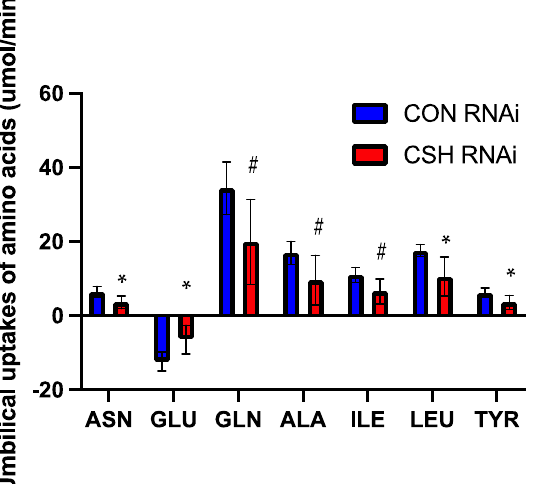
Figure 6. Umbilical uptakes (µmol/min) of amino acids as assessed by 3 H 2 0 transplacental diffusion at 130 dGA. Data are shown as means ± SEM for all pregnancies in each treatment group. CSH, chorionic somatomammotropin; RNAi, RNA interference. Ala, alanine; Asn, asparagine; Glu, glutamate; Gln, glutamine; Ile, isoleucine; Leu, leucine; and Tyr, tyrosine. * p ≤ 0.05, # p ≤ 0.10, when CSH RNAi pregnancies are compared with control RNAi